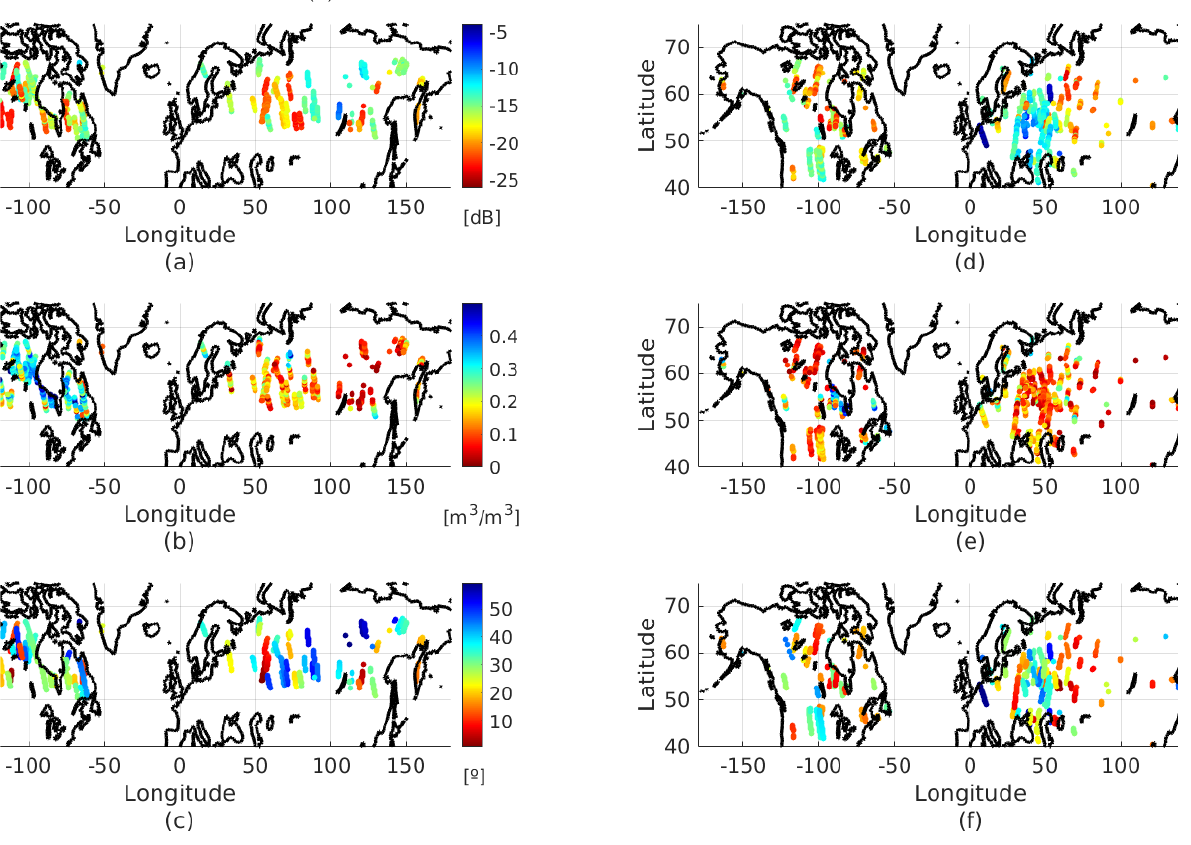
Figure 4. ( a , d ) GNSS-R reflectivity calibrated as shown in [37], ( b , e ) the SMOS SM (9 km) estimation interpolated over the GNSS-R specular reflection position, and ( c , f ) the incidence angle of the reflection. ( a – c ) from 1–31 October 2020 and ( d , e